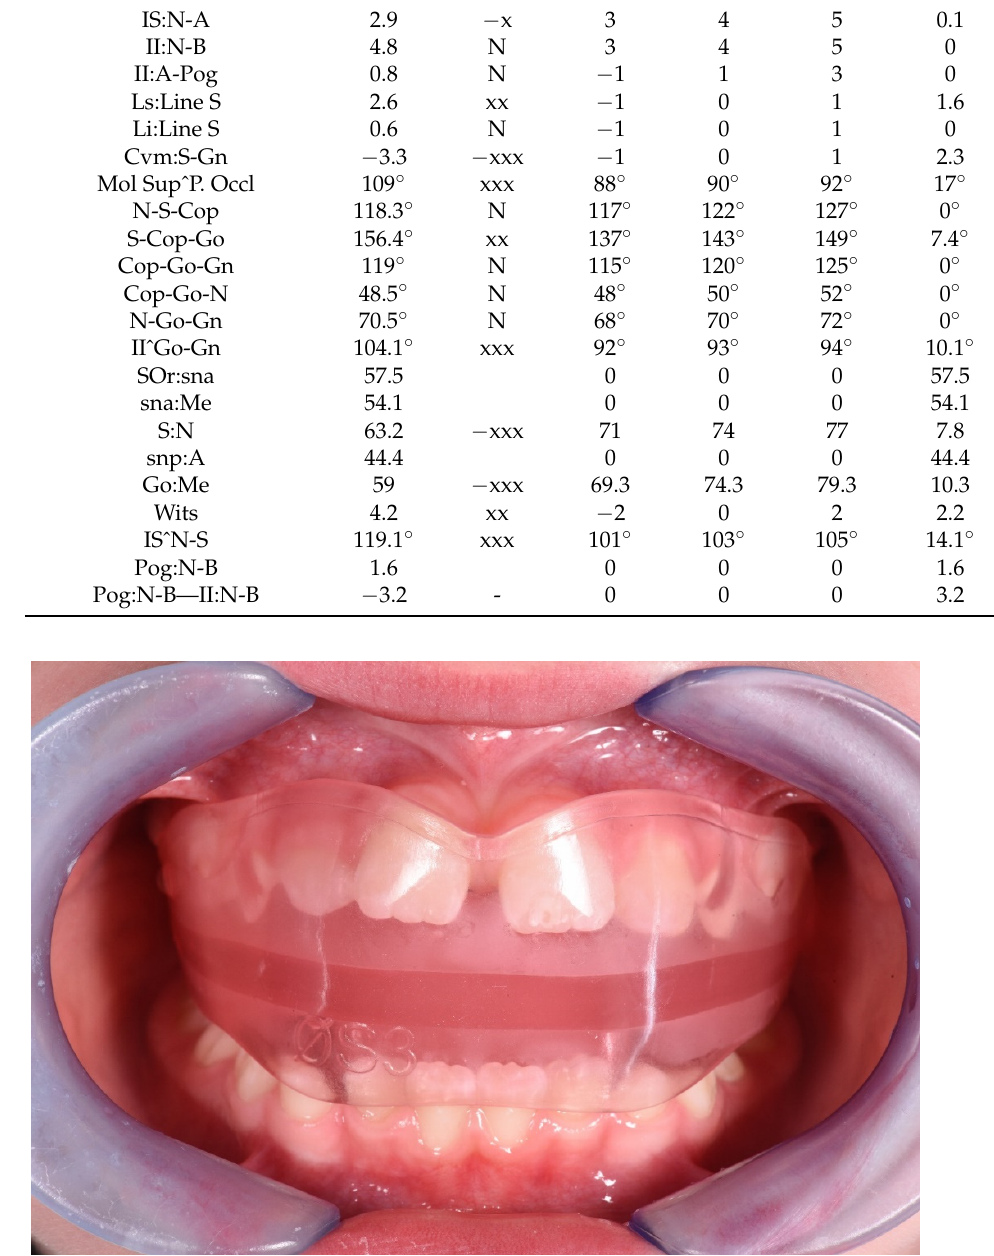
Figure 26. Intraoral photographs at the end of the treatment (9-year-old). ( A ) Frontal view; ( B , C ) lateral view. A